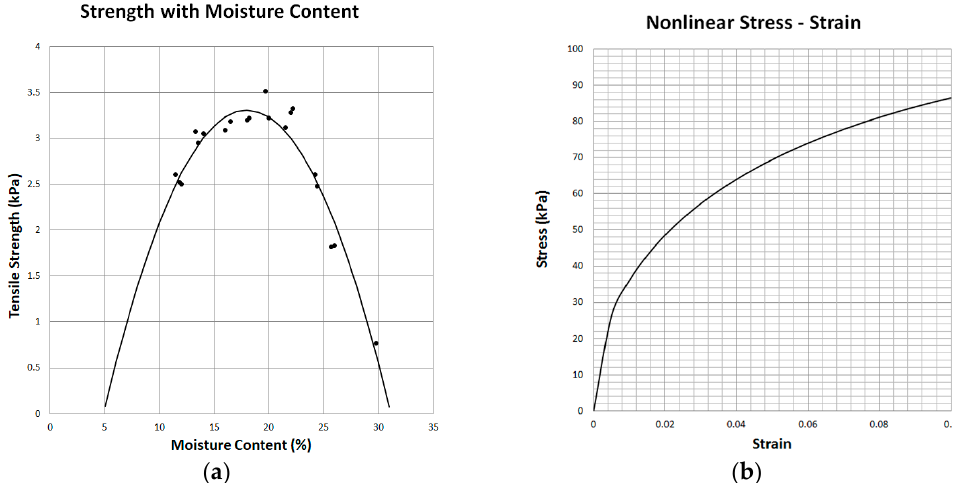
Figure 3. Crack initiation criteria: ( a ) tensile strength, moisture-content-dependent [12]; ( b ) traditional strength of material failure criteria [59].